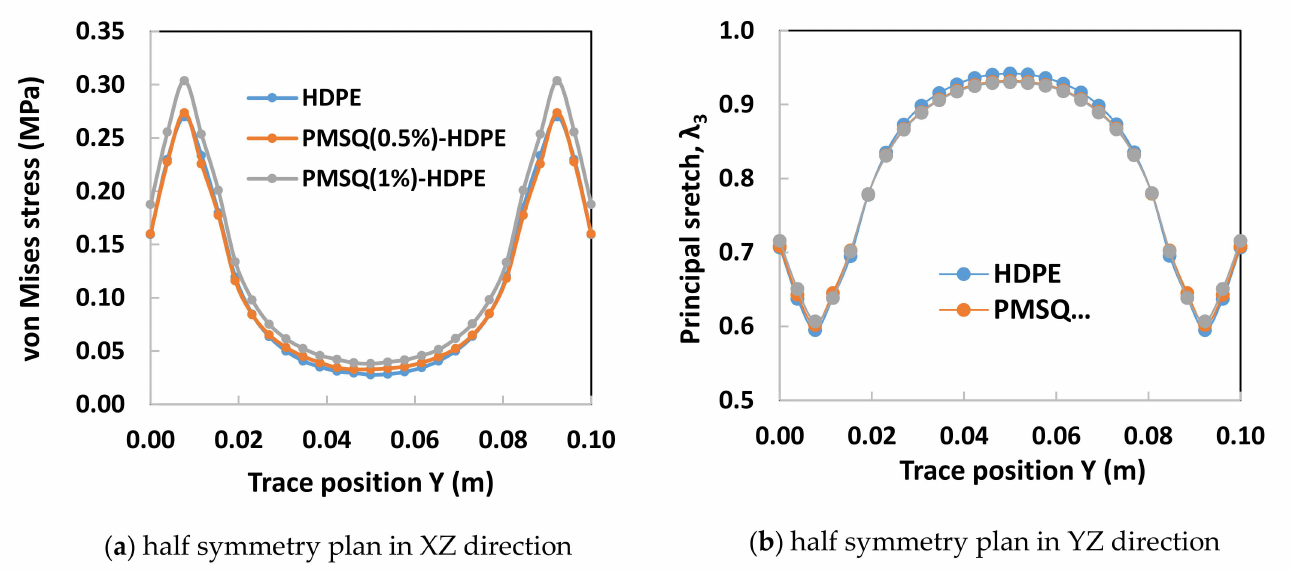
Figure 10. Von Mises stress on XZ and YZ half planes of symmetry of the blade.